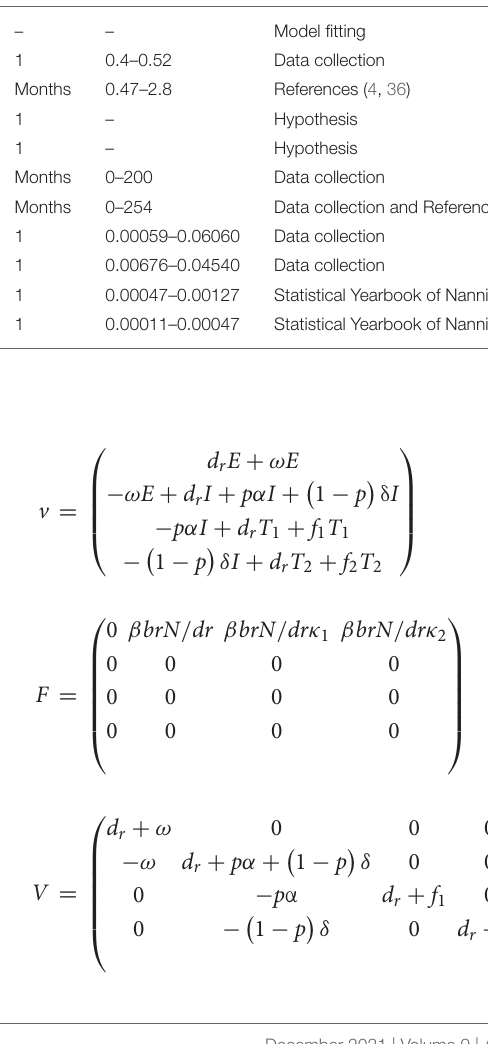
TABLE 2 | Definition and value of parameters in HIV transmission dynamics model.